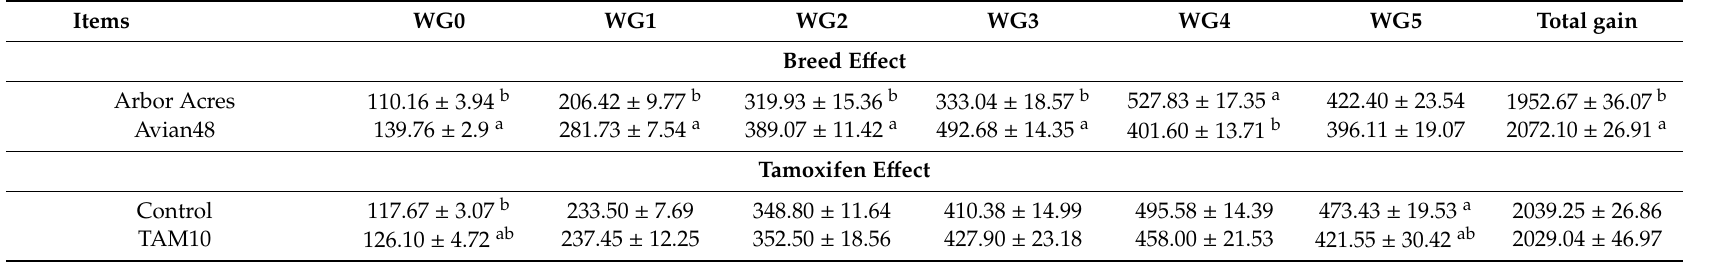
Table 3. The e ff ect of breed, Tamoxifen treatments and their interactions on weekly weight gain (Means ±